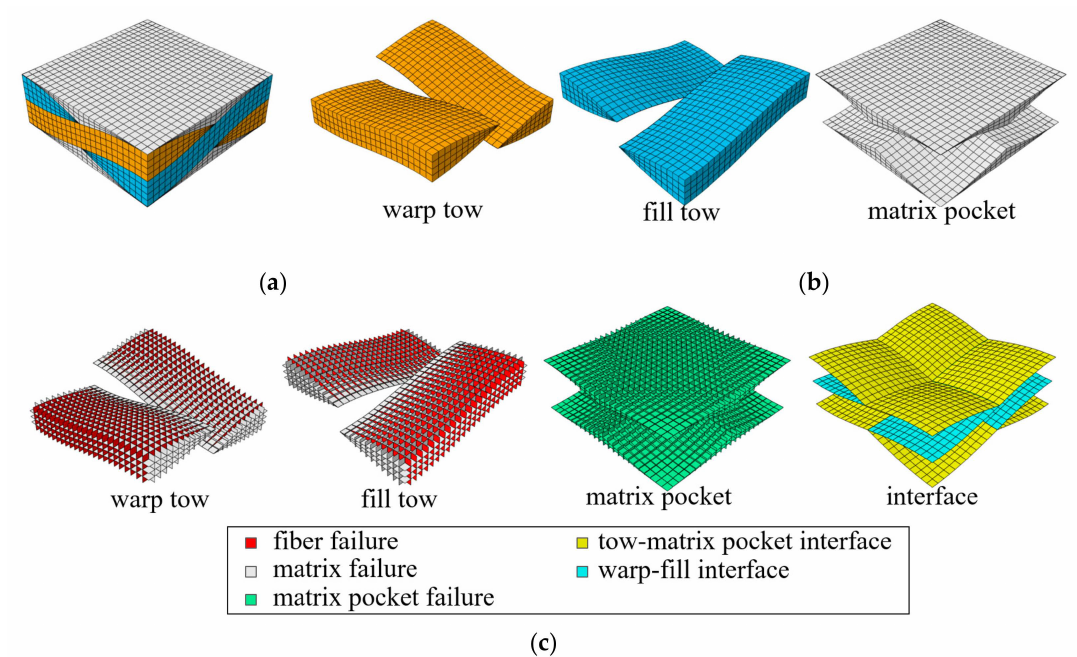
Figure 5. Finite element mesh of single-ply repeating 1/4-unit cell: ( a ) 1/4-unit cell mesh (bulk and cohesive elements); ( b ) bulk elements; and ( c ) cohesive elements.